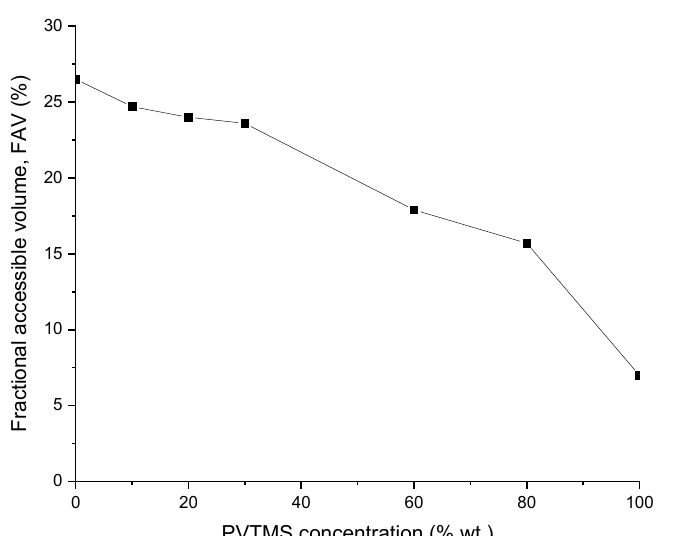
Figure 6. Change in the proportion of the FAV of PTMSP/PVTMS blend materials depending on the content of PVTMS.